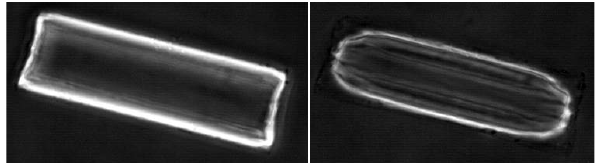
Fig. 11. Optical microscopy images of an ice analogue crystal in subsaturated sodium fluorosilicate solution at the start of dissolv- ing (left) and after approximately 20min (right). Initial crystal di- mensions were 120 by 37µm. Phase contrast was used and contrast stretching applied to emphasize the small difference in the refractive index of the solution (1.33) and the crystal (1.31). The numerical aperture of the objective was 0.4.